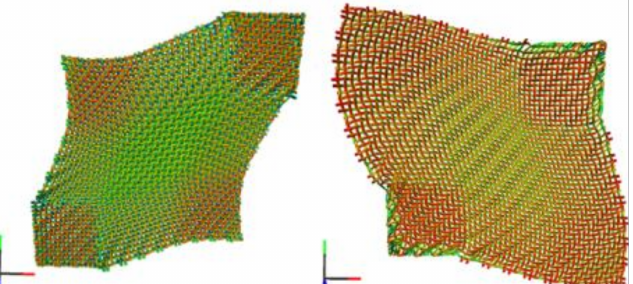
Figure 5. Simulation under the same boundary conditions and applied tension: without thermal expansion in yarns and with an